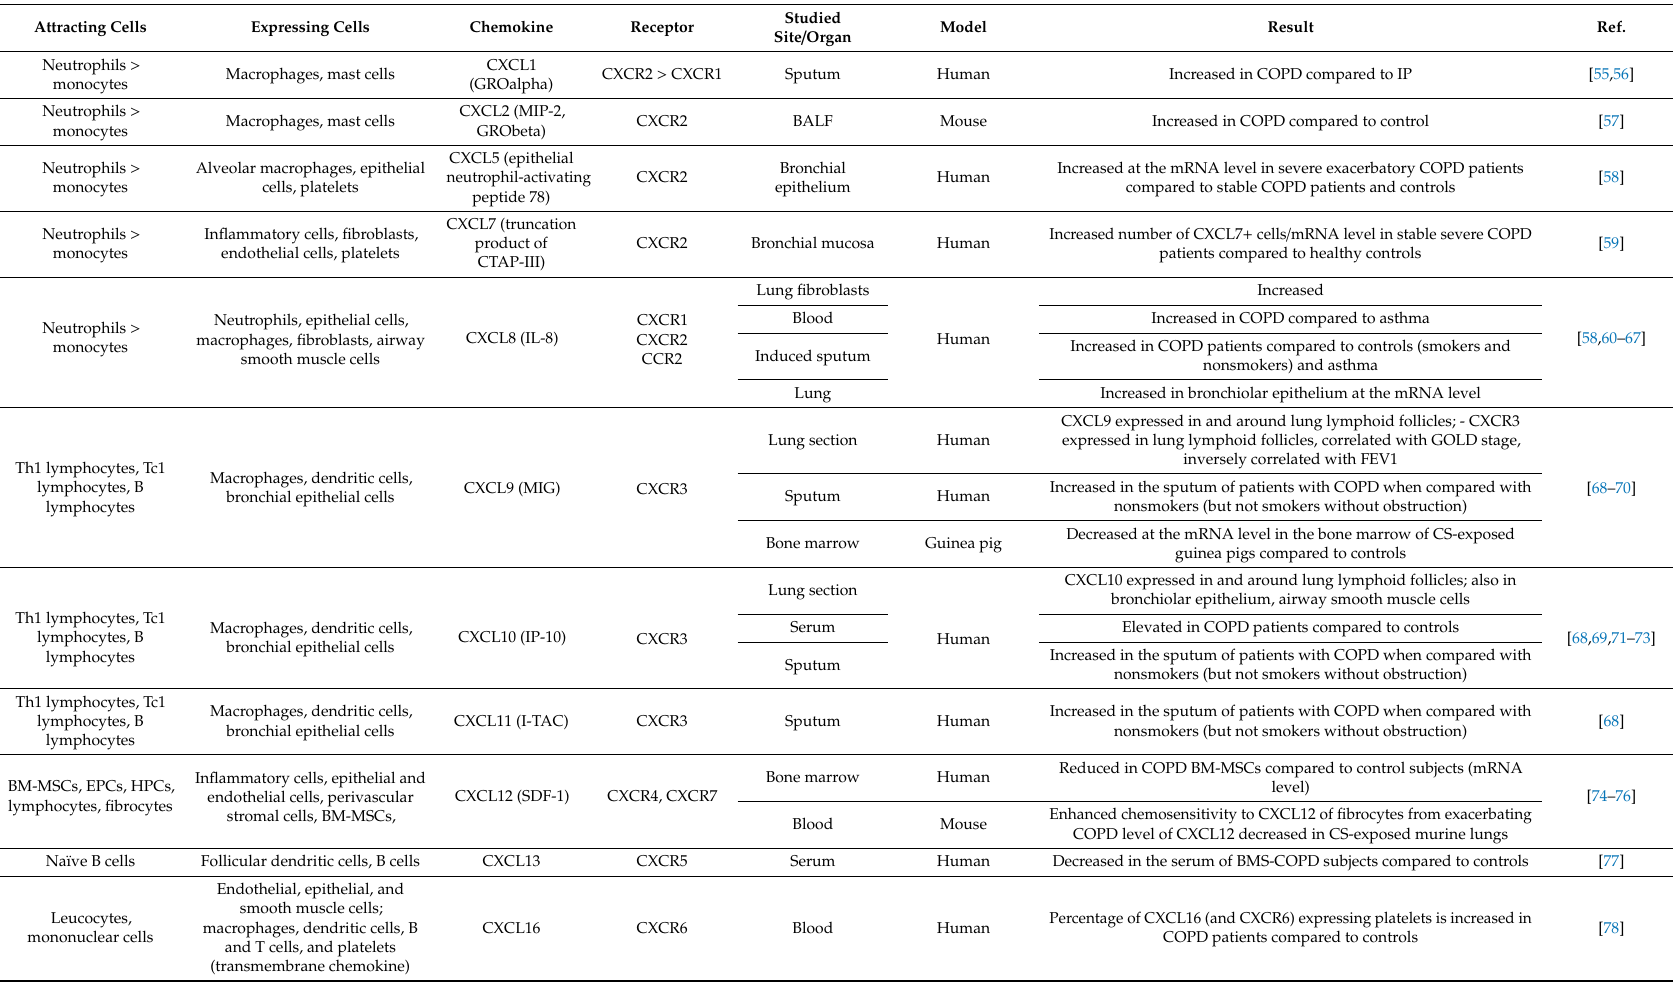
Table 1. Chemokines implicated in Chronic Obstructive Pulmonary Disease